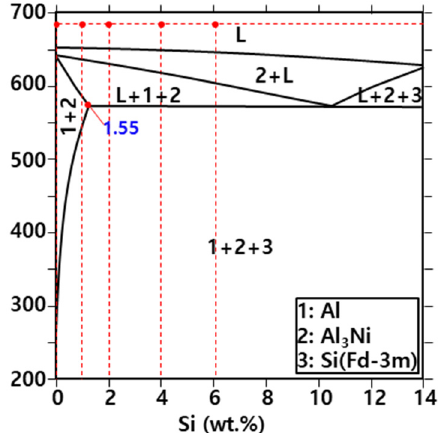
Figure 4. Portion of (Al–7Ni)– x Si quasi ‐ binary phase diagram calculated using Thermo ‐ Calc™.